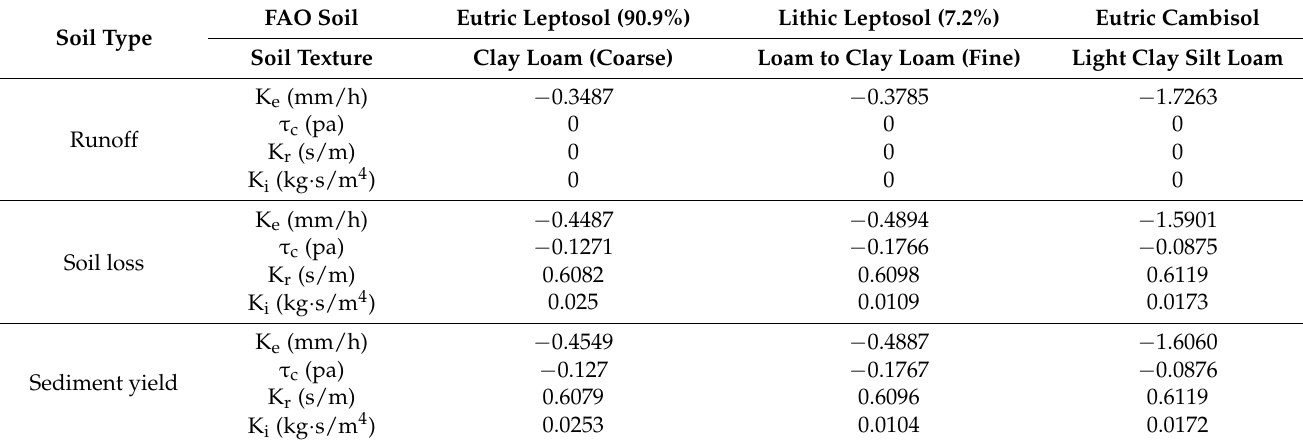
Table 2. Sensitivity ratio for the Angereb sub-watershed by soil